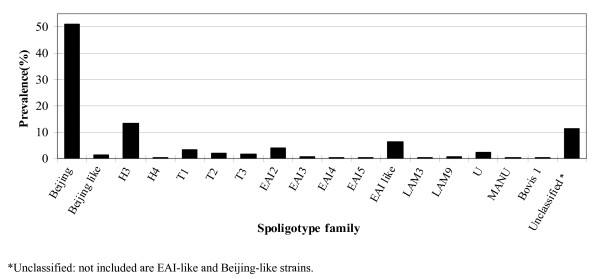
Prevalence of the major spoligotype families and subfamilies of 356 M. tuberculosis isolates.